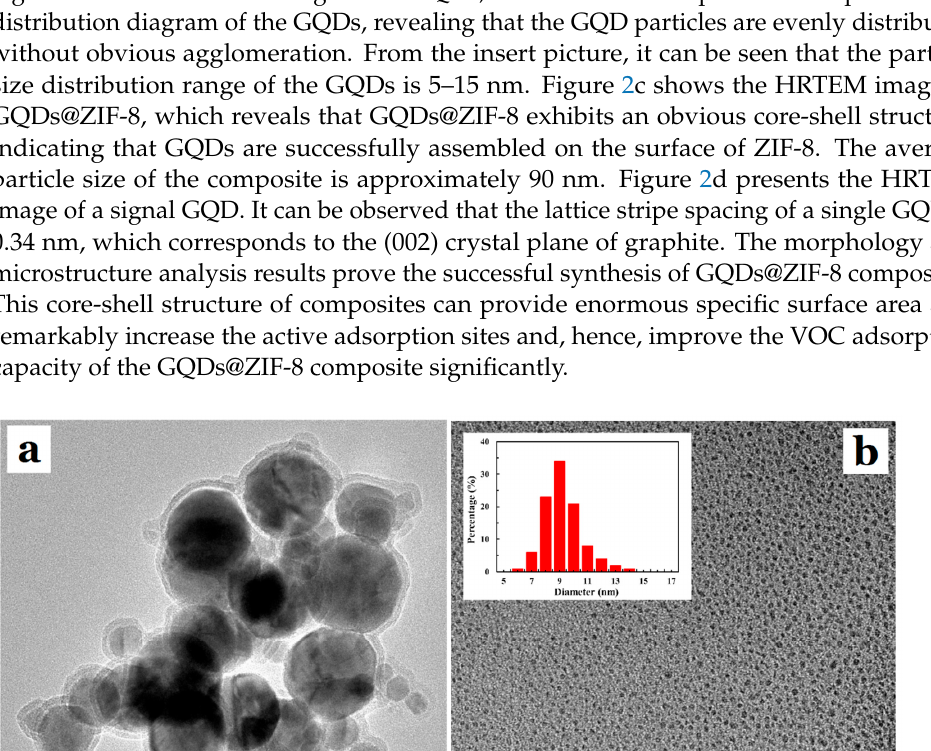
Figure 2. Morphology and microstructure images of GQDs@ZIF-8 composites. ( a ) TEM image of GQDs@ZIF-8, ( b ) TEM image of GQDs with diameter distribution graph, ( c ) HRTEM image of GQDs@ZIF-8, ( d ) HRTEM image of a signal GQD. 3.2. Crystalline Structure and Chemical Bond Analysis of GQDs@ZIF-8 Composites Figure 3 exhibits the measured XRD pattern of the composites and the standard XRD pattern of ZIF-8. The XRD pattern of GQDs@ZIF-8 is similar to that of pure ZIF-8, and the diffraction peaks of ZIF-8 and GQDs@ZIF-8 are consistent with the standard peaks of ZIF-8 (Figure 3b) [34]. The 2 θ values of the strong diffraction peaks are 7.3°, 10.3°, 12.7°, 14.7°, 16.4°, 18°, 24.6° and 26.7°, which correspond to the (011), (002), (112), (022), (013), (222), (233) and (134) planes of ZIF-8, respectively. In addition, the diffraction peak shape of GQDs@ZIF-8 changes due to the introduction of GQDs, and the pattern of the composite does not show the characteristic peak (25°) of the GQDs, which is due to